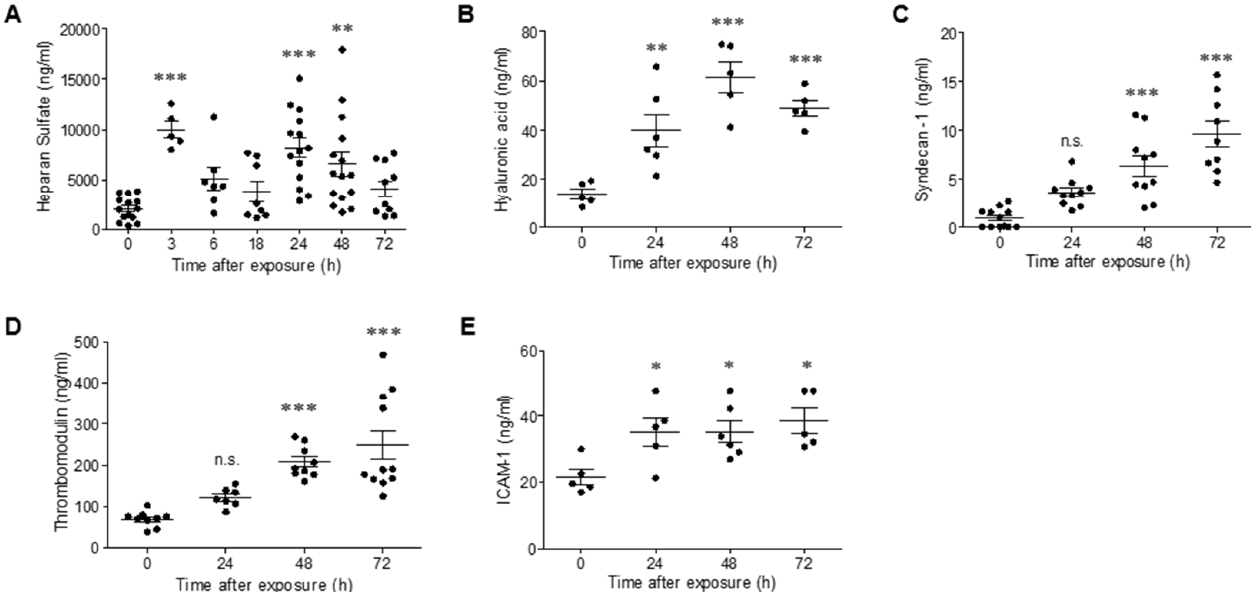
Figure 2. Degradation of the glycocalyx in ricin-intoxicated mice. Circulating levels of HS ( A ), HA ( B ), syndecan-1 ( C ), thrombomodulin ( D ) and ICAM-1 ( E ) were determined in serum samples collected from non-intoxicated (0 h) and ricin- intoxicated (2LD 50 i.m., 18 µg ricin/kg) mice at the indicated time points. Each dot represents an individual mouse. The results are depicted as means ± SEM. Statistical analyses were performed by one-way ANOVA followed by Dunnett’s post hoc test. * p < 0.05; ** p < 0.01; *** p < 0.001; n.s., not significant.